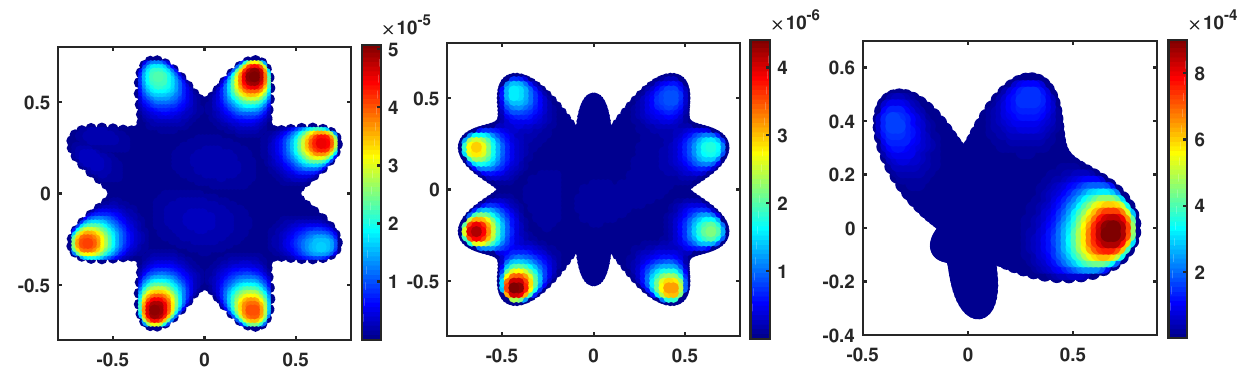
Figure 11. E 2 –error function at T = 1 with τ = 0.1 in Ω 1 , Ω 2 , and Ω 3 for Example 3.